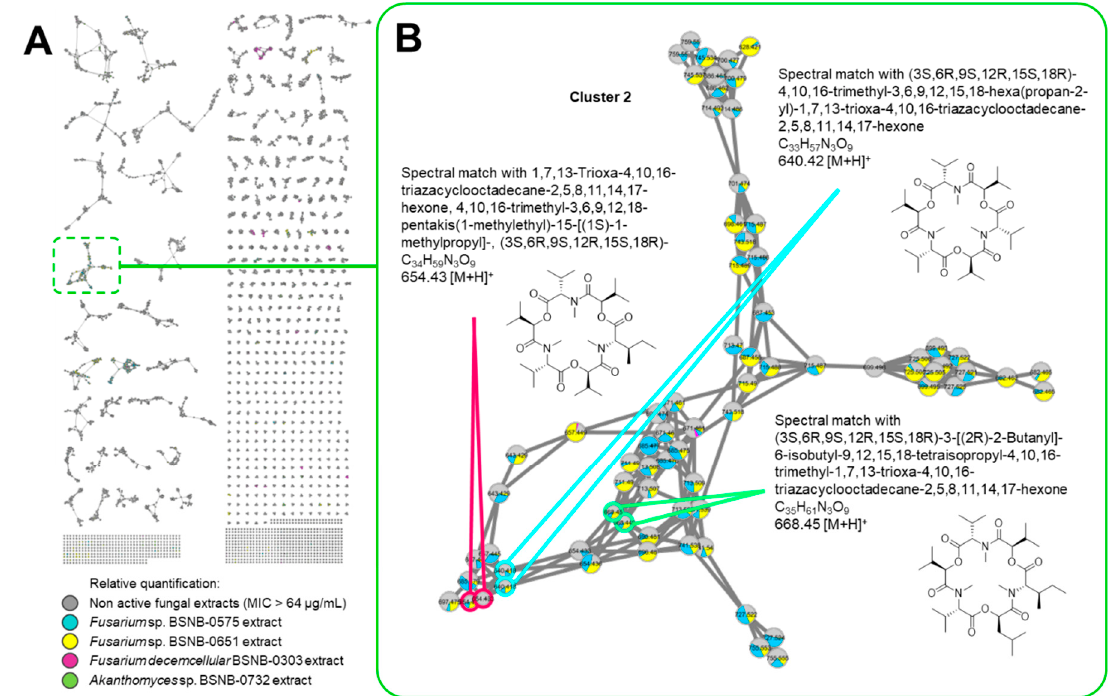
Figure 1. ( A ) Molecular network (MN) of the 131 extracts from fungal endophytes. Relative quantification values of each ion within the extracts are represented as an extracted ion chromatograph (XIC) area-dependent pie chart. ( B ) Dereplication process nodes belongings to cluster 2 composed by ions from the extracts of BSNB-0575 and BSNB-0651. Cluster 2 appears to group the ions corresponding to depsipeptides metabolites. MIC, Minimal Inhibitory Concentration.